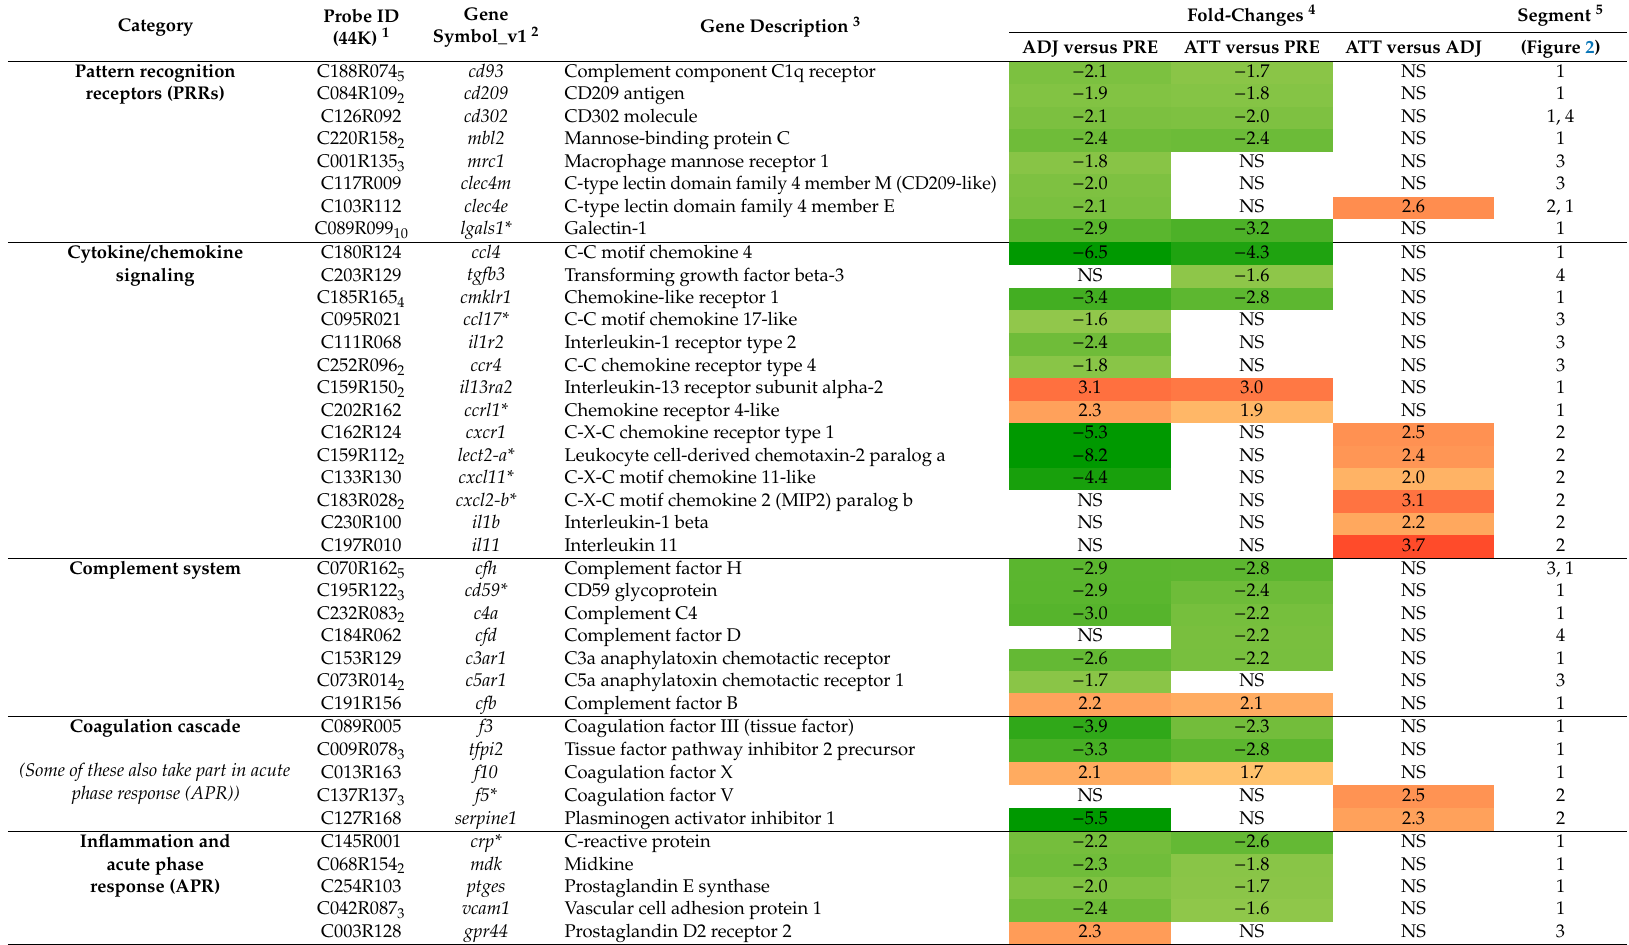
Table 2. Selected transcripts associated primarily with di ff erent components of the immune system and their fold-change values from SAM.